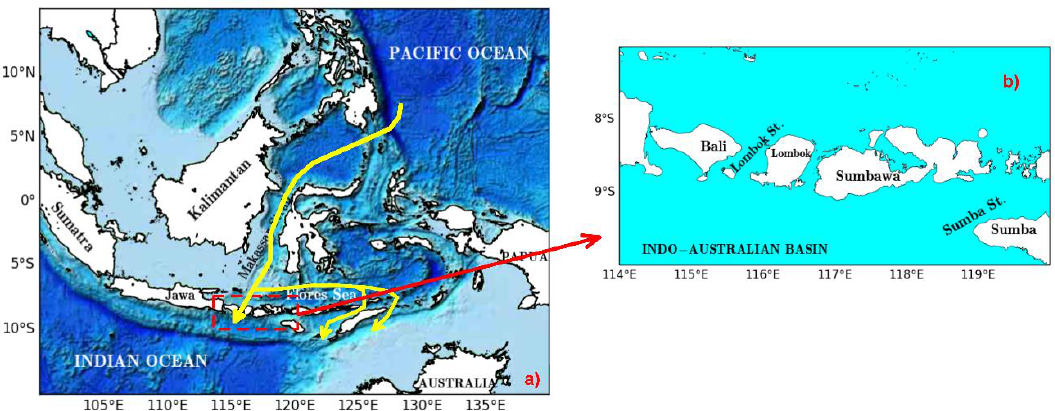
Figure 1. ( a ) The Indonesian archipelago; yellow arrow shows the water exchange between the Pacific and Indian Oceans. ( b ) The location of Lombok Strait in the Indonesian archipelago. Hydrophysical characteristics of the Lombok Strait.